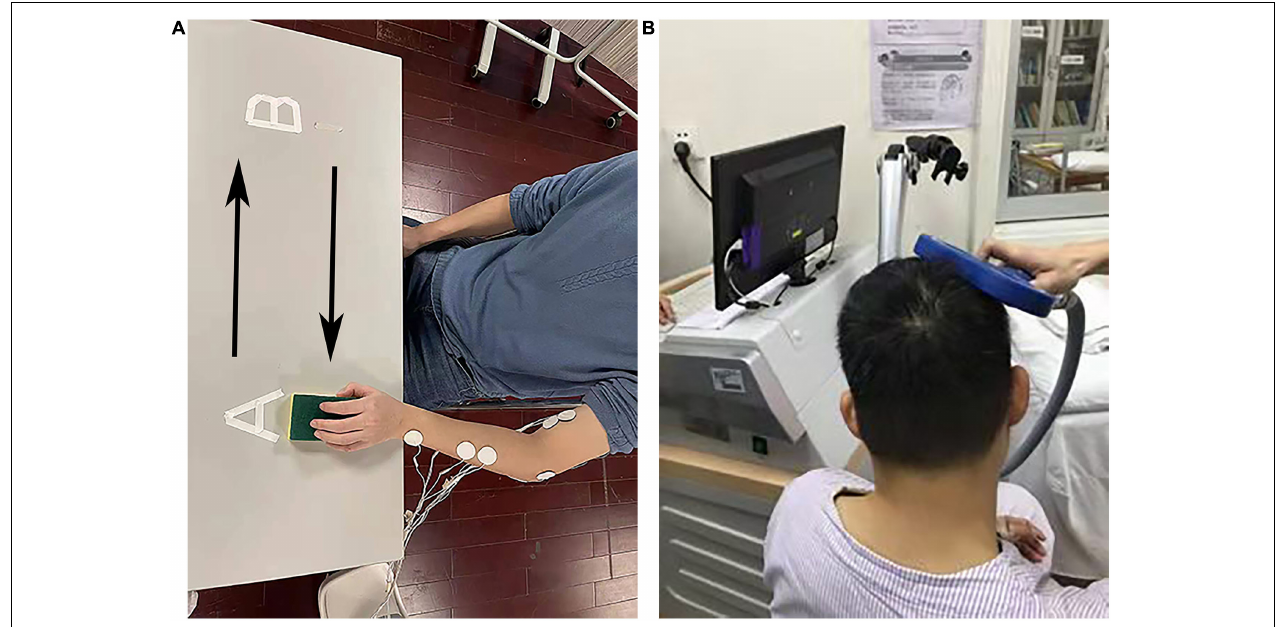
FIGURE 1 | The experimental setup. (A) The electromyography (EMG) evaluation during horizontal task. (B) The experimental setup for motor-evoked potentials (MEP)